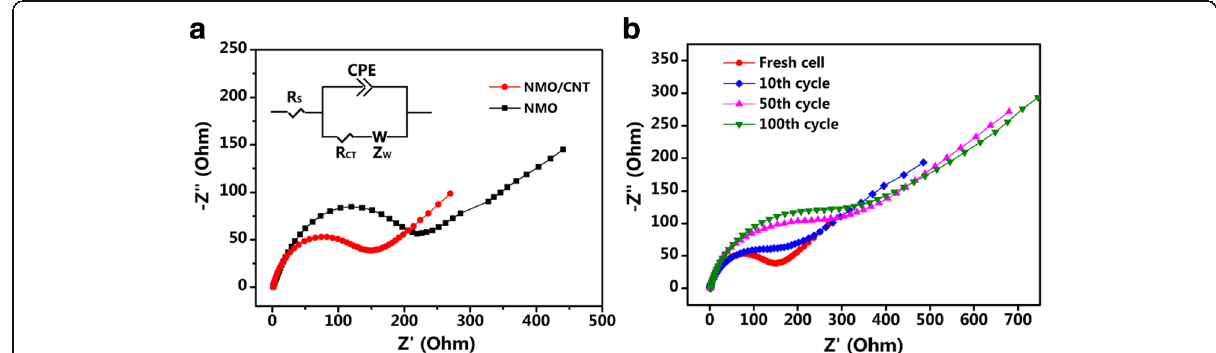
Fig. 7 (a) EIS spectra of NMO and NMO/CNT electrodes at the fresh cycle and the equivalent circuit model of plot fitting ( inset ). (b) EIS spectra of NMO/CNT electrode at the fresh cell, 10th, 50th, and 100th